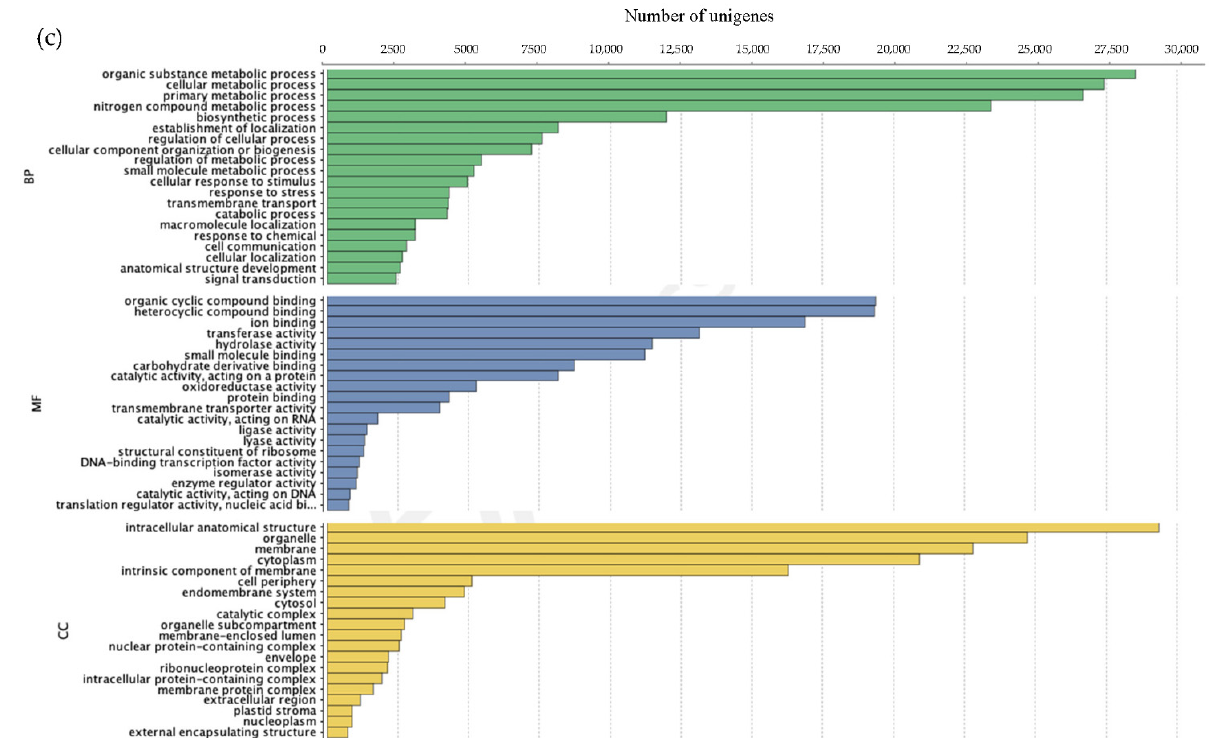
Figure 8. Annotation of GO terms from categories of biological process (BP), molecular function (MF), and cellular components (CC) for ( a ) H. cagayanensis; ( b ) H. lacunosa , and ( c ) H. coriacea. Only the top 20 terms for each category shown.